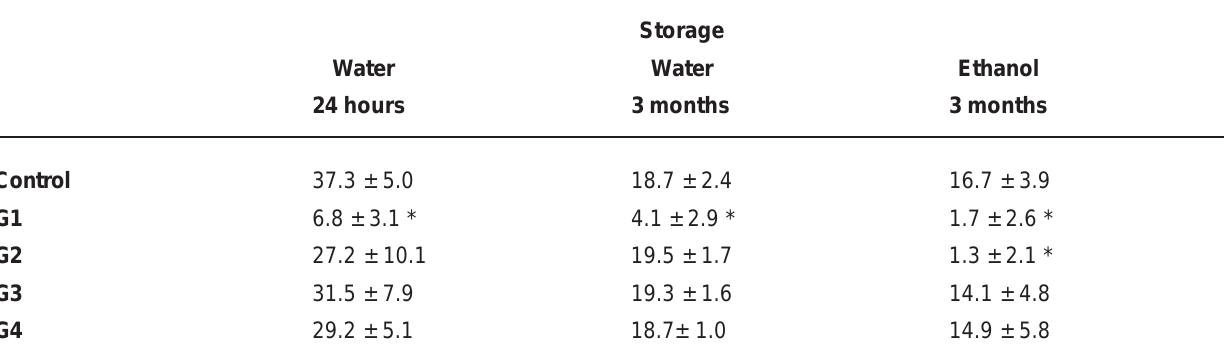
TABLE 1- Shear bond strength means (MPa) and standard deviation (SD) for each storage protocol and surface treatment. Values marked with an asterisk (*) are significantly different from the control (p < 0.05)